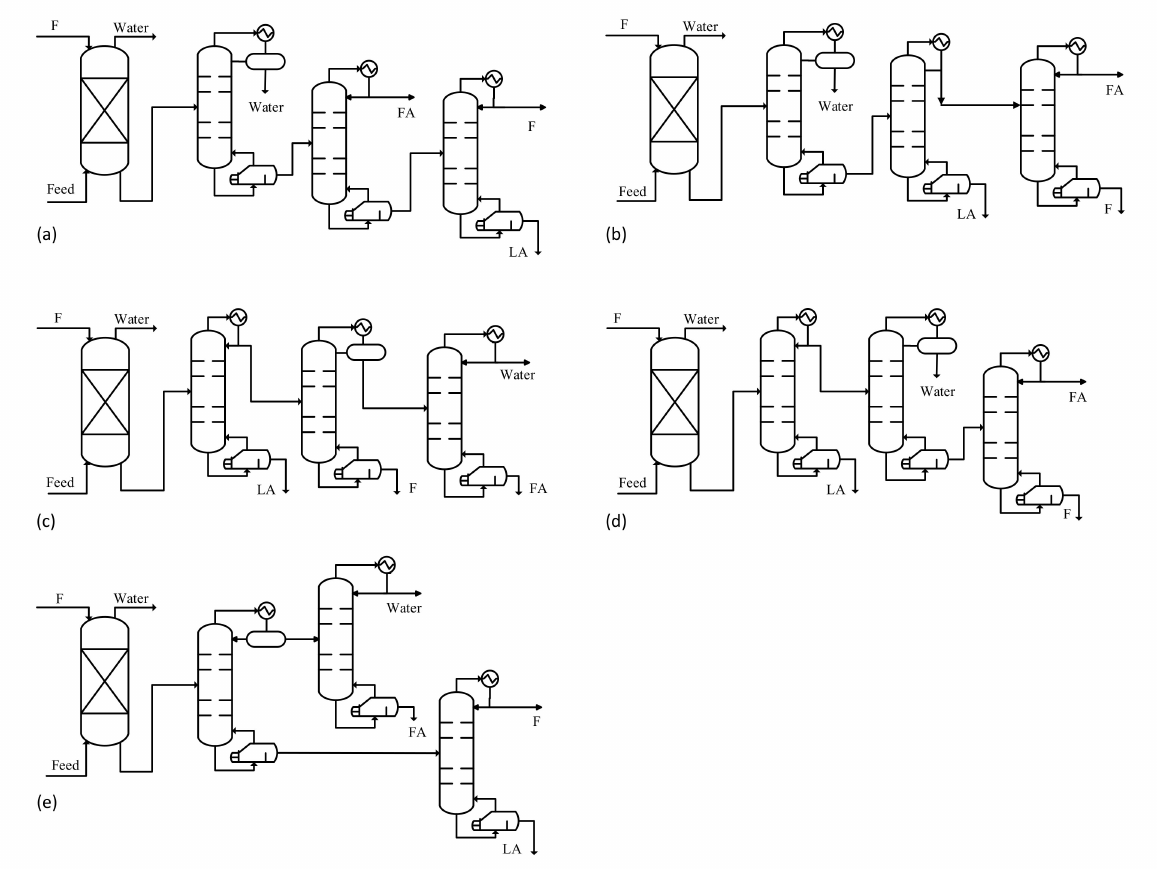
Figure 1. Liquid-liquid (LL) assisted ordinary distillation, ( a ) LL-assisted direct distillation sequence (LL-D), ( b ) LL-assisted direct-indirect sequence (LL-DI), ( c ) LL-assisted indirect sequence (LL-I), ( d ) LL-assisted indirect-direct sequence (LL-ID), ( e ) LL-assisted symmetrical sequence